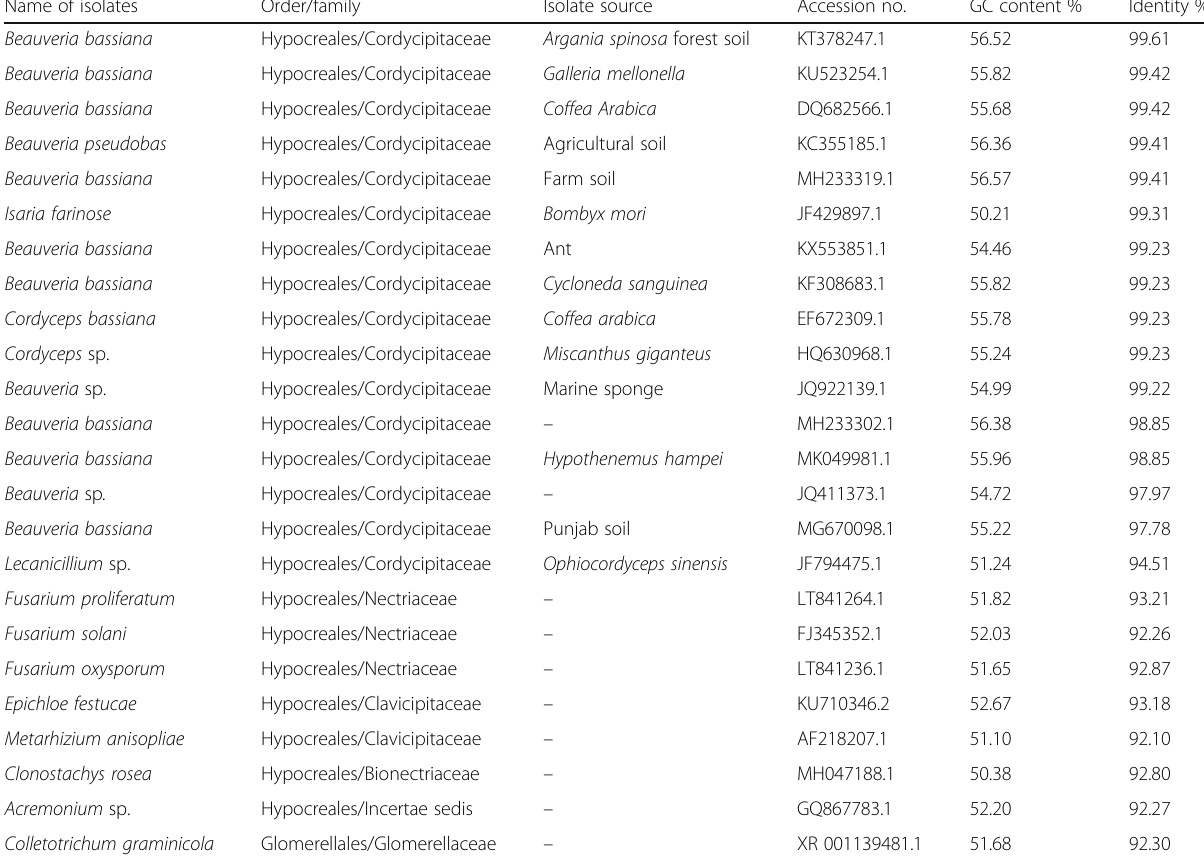
Table 1 Species used in the phylogenetic analysis of ITS1 gene region of the present Beauveria bassiana Name of